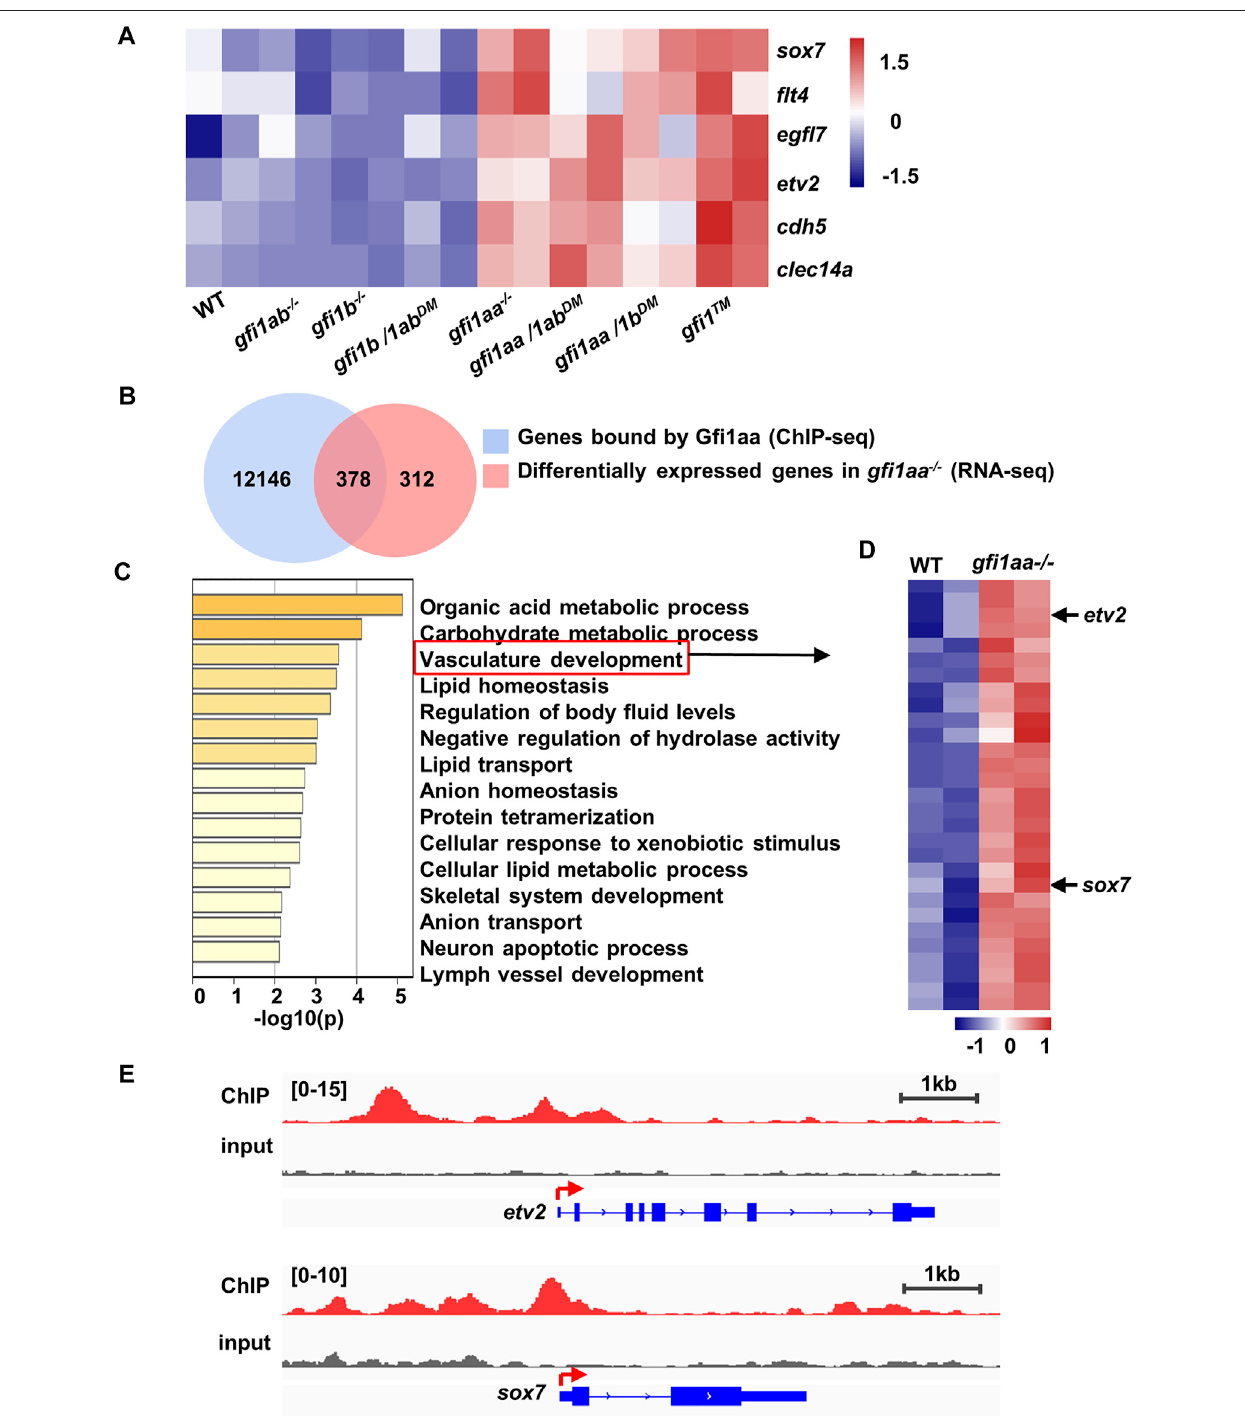
FIGURE 2 | G fi 1aa could bind to etv2 and sox7 regulator regions (A) Endothelial genes were increased in g fi 1aa related mutants. Heatmap of WT, g fi 1aa − / − , g fi 1b − / − , g fi 1ab − / − signal mutant, g fi 1aa/1b DM , g fi 1aa/1ab DM , g fi 1b/1ab DM double mutant and g fi 1 TM triple mutant showed the gene expression levels of endothelial genes( sox7 , fl t4 , cdh5 , clec14a , etv2, and eg fl 7 ).Thecolorscaleindicatedtheexpressionlevel (B) Combinationalanalysisof g fi 1aa − / − RNA-seqandG fi 1aa-eGFPChIP- seq. 378 genes were overlapped between 690 up-regulated genes in g fi 1aa − / − mutant and 12,524 genes bound by G fi 1aa (C) Go enrichment analysis of the 378 combinational genes. Vasculature development GO term was indicated by the red box (D) Heat map of WT and g fi 1aa − / − mutant showed the vasculature development genes expression levels from (C) . The color scale indicated the expression level (E) Visualization of G fi 1aa binding sites on etv2 (top) and sox7 (bottom) indicated by G fi 1aa ChIP-seq (red) compared to input control (grey) through integrative genomics viewer (IGV).